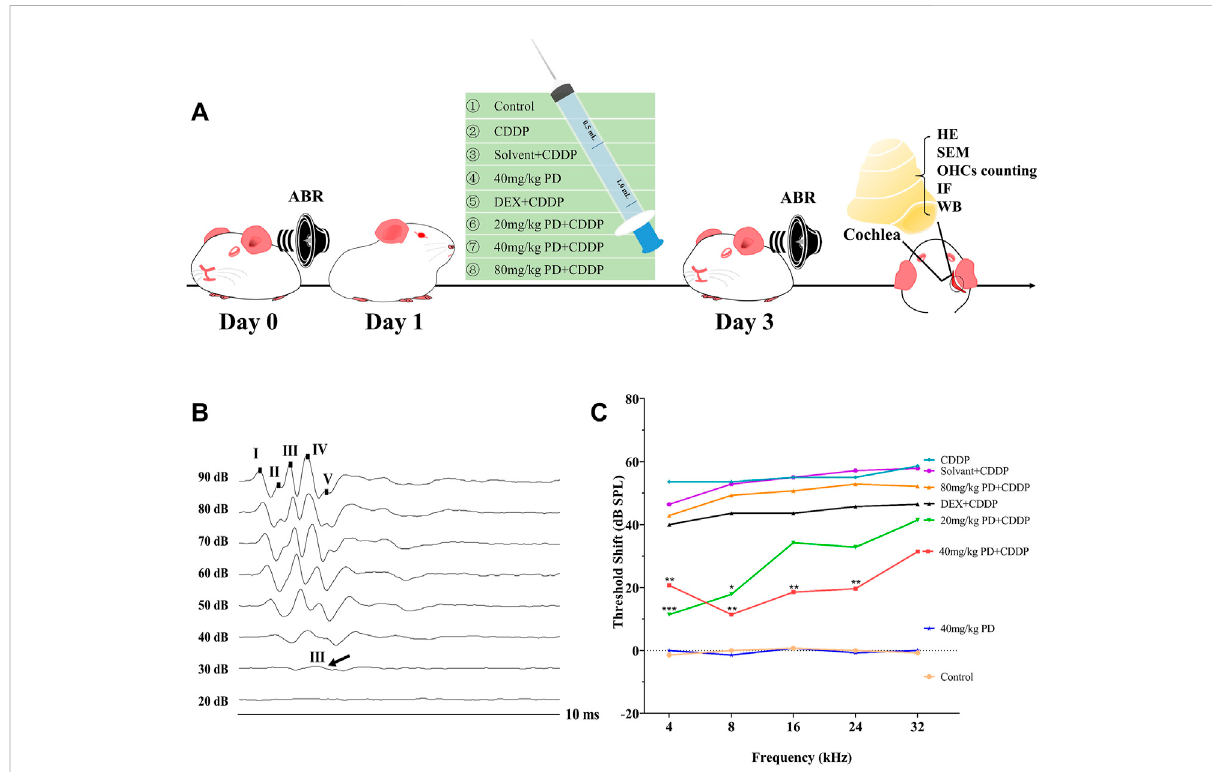
FIGURE 1 PD reduces the ABR threshold shift induced by cisplatin in guinea pigs. (A) Experimental groups and experimental operations taken at corresponding time points. (B) These are representativeplots oftheABR detection ofthe control group. Wave III wasthe mostprominent and stable in the ABR detection. (C) Comparison of ABR threshold shift among each group. PD (40 mg/kg) showed good hearing protection at 4, 8, 16, and 24 kHz after injection of CDDP, which was better than DEX (10 mg/kg, multi-dose intraperitoneal administration). PD alone had no effect on hearing in guinea pigs. n = 7. Data were presented as mean ± SEM. * p < 0.05, ** p < 0.01, and *** p < 0.001, all versus the CDDP